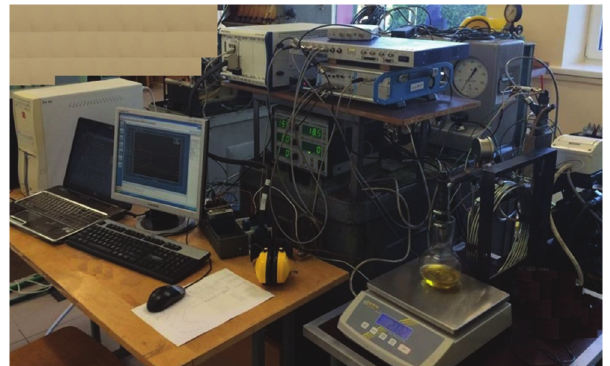
Fig. 1. Test stand used in the